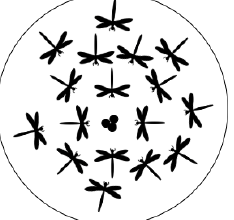
Figure 1. Static Swarm [2,5,6].